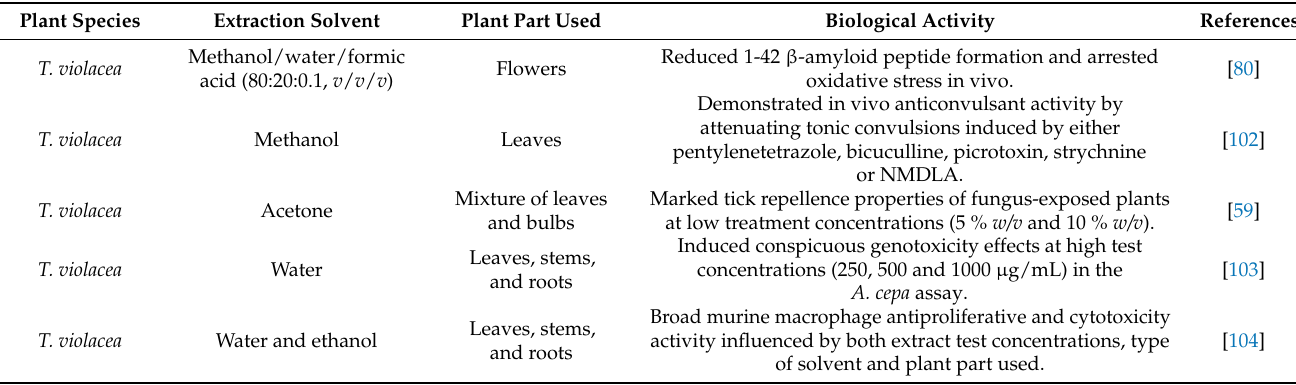
Table 8. Miscellaneous biological properties of extracts of Tulbaghia